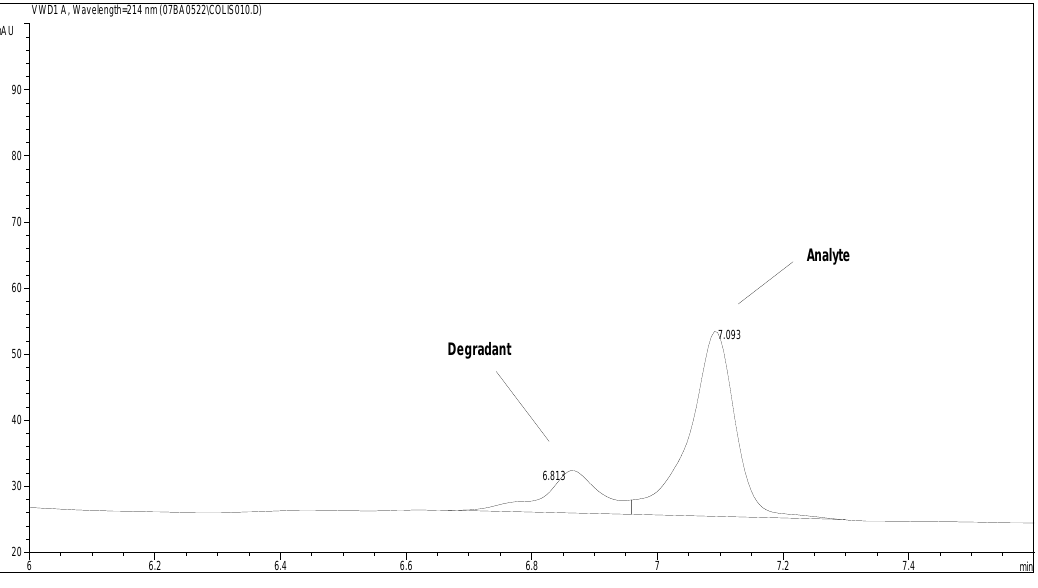
Figure 3. An example chromatogram of a nonstability-indicating HPLC method that evaluates the analyte and degradant peaks that are not fully resolved from one